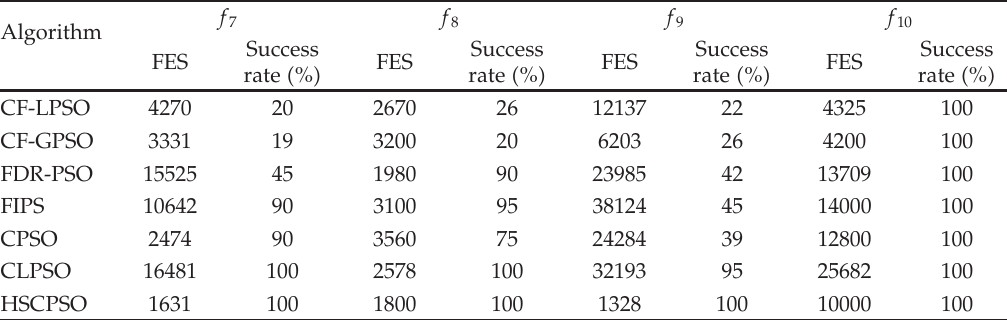
Table 7: Robustness analysis after 6